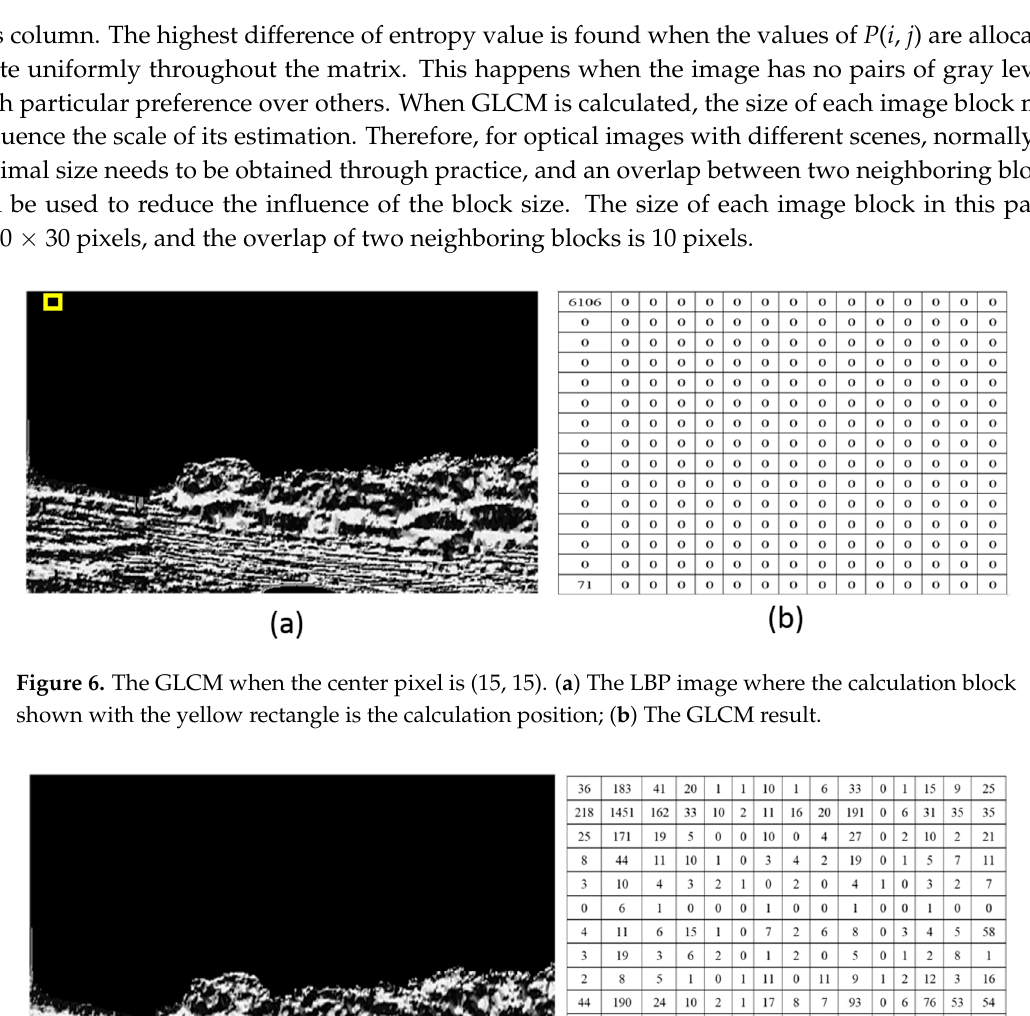
Figure 8. The entropy differential curve when two areas exist. ( a ) The LBP image where the calculation position is shown with the green dashed line; ( b ) The entropy differential curve.